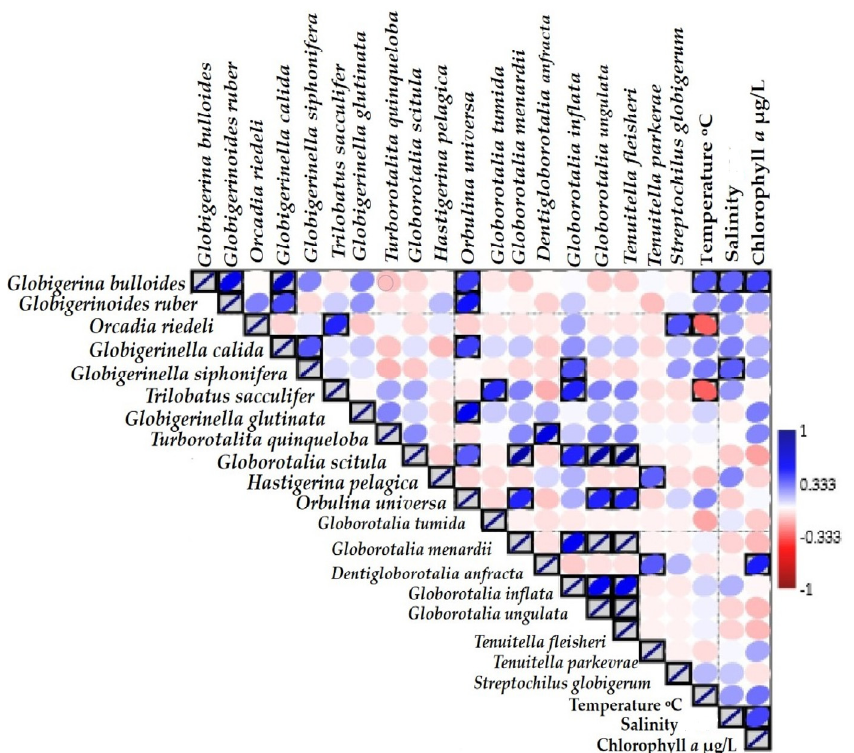
Figure 8. Pearson correlation analysis plots for the dominant foraminifera species with temperature, salinity, and Chlorophyll- a variables. The grey boxes indicate the significant value ( p < 0.05), the red dot indicates a negative correlation, and the dark blue dot is the sign of positive correlation values. Table 3. The Pearson correlation c° efficient values of the dominant foraminifera species and three integrated ocean environmental variables.